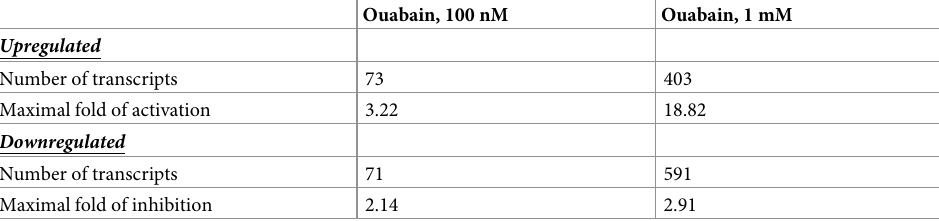
Table 2. Number of differentially expressed transcripts in ouabain-treated rat cerebellum granule